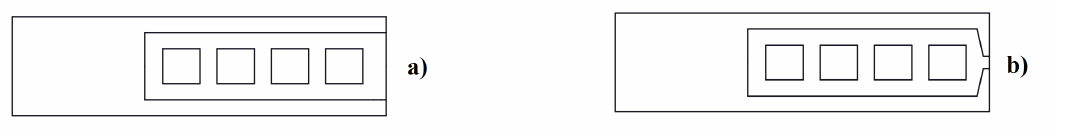
Figure 8. Rectangular slot with the widest ( a ) and the narrowest slot opening ( b ).